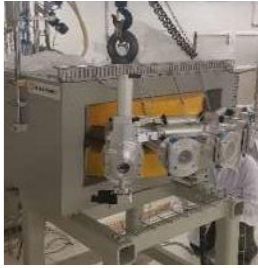
Fig. 11. 5-port magnet installed in the R&D room of the TAEA SANAEM PAF. METU-DBL beamline follows from the right- most exit of this magnet.